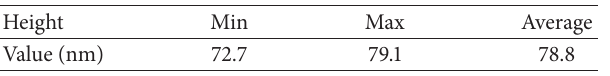
Figure 8: Height distribution.